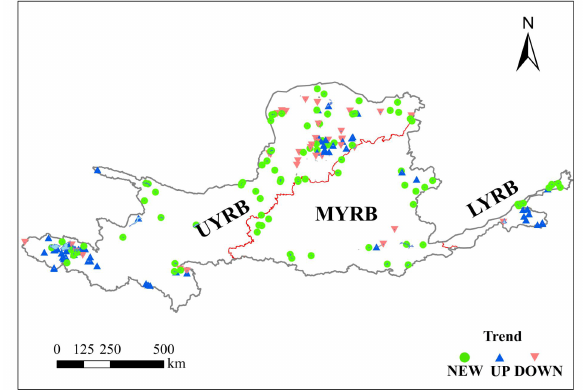
Figure 8. Spatial and temporal trends of lakes and reservoirs in the YRB from 2000 to